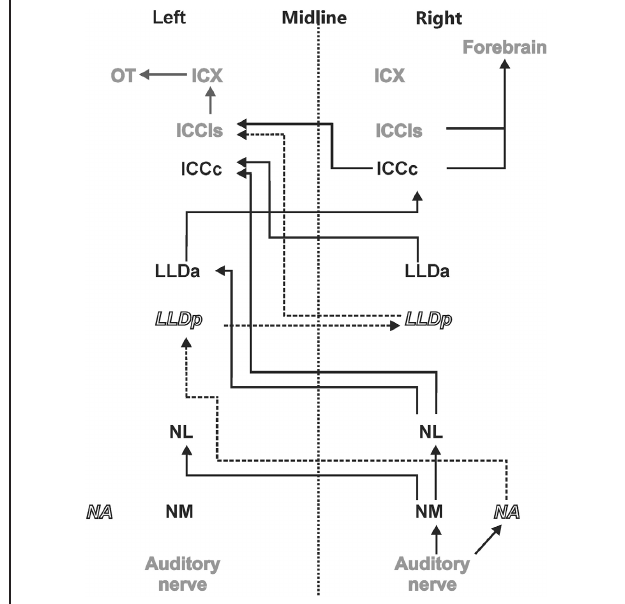
FIGURE 1 | Auditory pathway. The afferent auditory pathway is schematically illustrated starting from the auditory nerve upstream to the optic tectum (OT) where the auditory and visual maps merge. Nuclei mentioned in black transmit only ITD information (black solid lines) whereas nuclei indicated in white underlie processing of ILDs and their precursors only (dashed lines and italics). Nuclei shown in gray are involved in the processing of both ITD and ILD